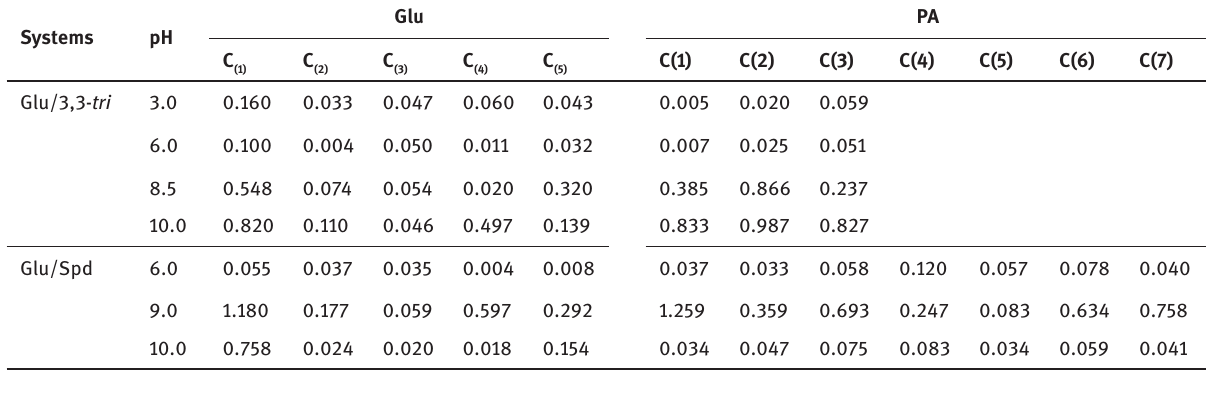
Table 2: Differences between 13 C NMR chemical shifts for the ligands in the Glu/triamine systems in relation to the free isolated ligands [ppm]. Glu PA Systems pH C (1) Glu/3,3-